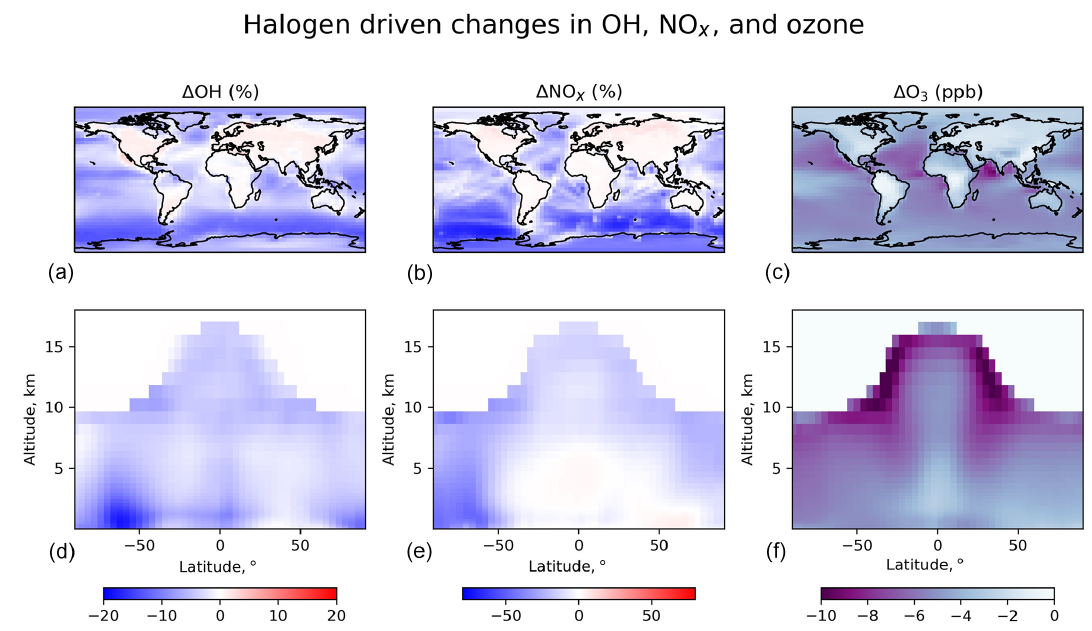
Figure 13. Effects of halogen chemistry on tropospheric OH, NO x , and ozone concentrations. The figure shows differences in annual mean concentrations between the standard simulation and a sensitivity simulation removing all tropospheric halogen reactions. The panels (a–c) are for surface air, and the panels (d–f) are for zonal means as a function of latitude and latitude. Only tropospheric grid boxes are shown.